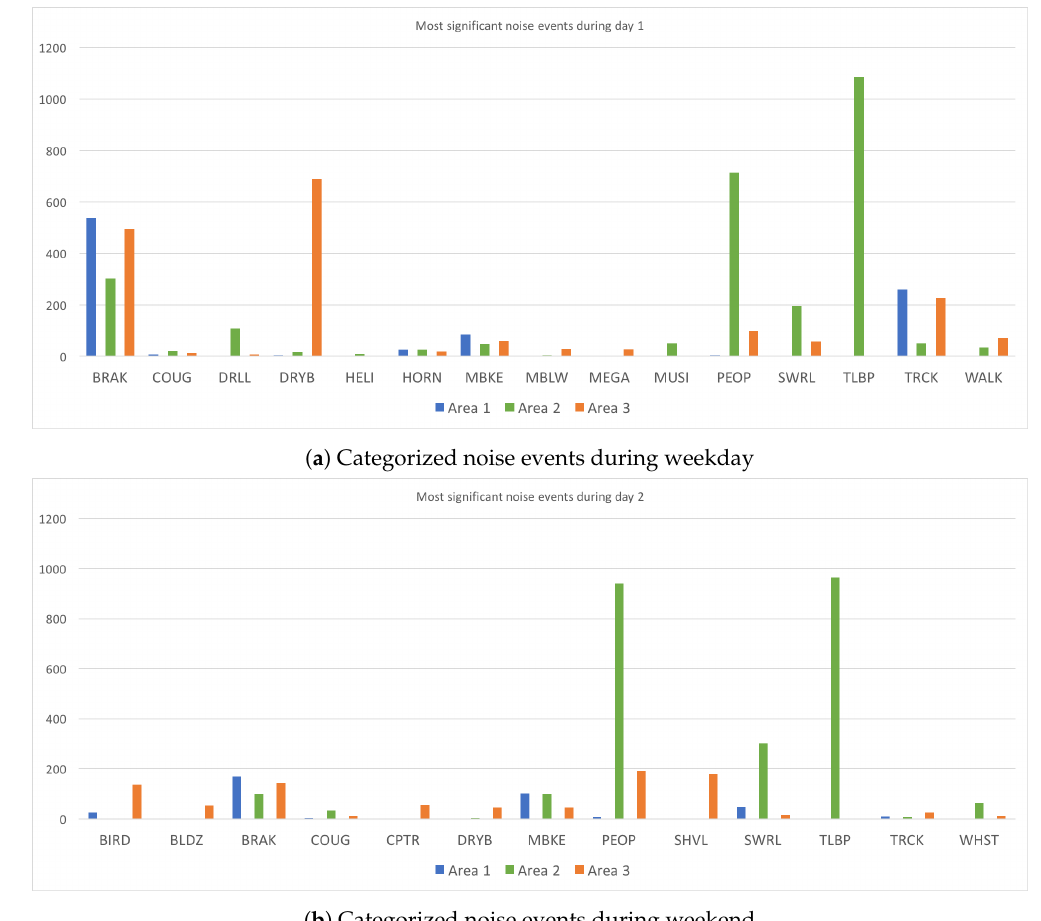
Figure 5. Bar graphs comparing all labeled events in all three pilot areas during the two recorded